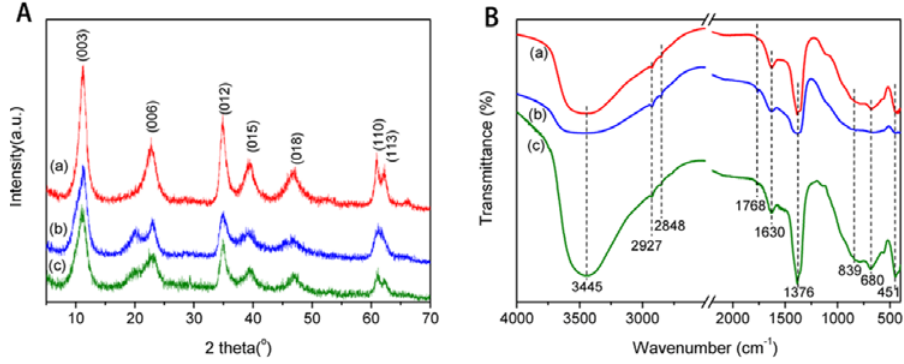
Figure 2. ( A ): XRD pattern; ( B ) IR spectrum of LDHs. ( a ) LDH-Ni; ( b ) LDH-Co; ( c ) LDH-Cu.